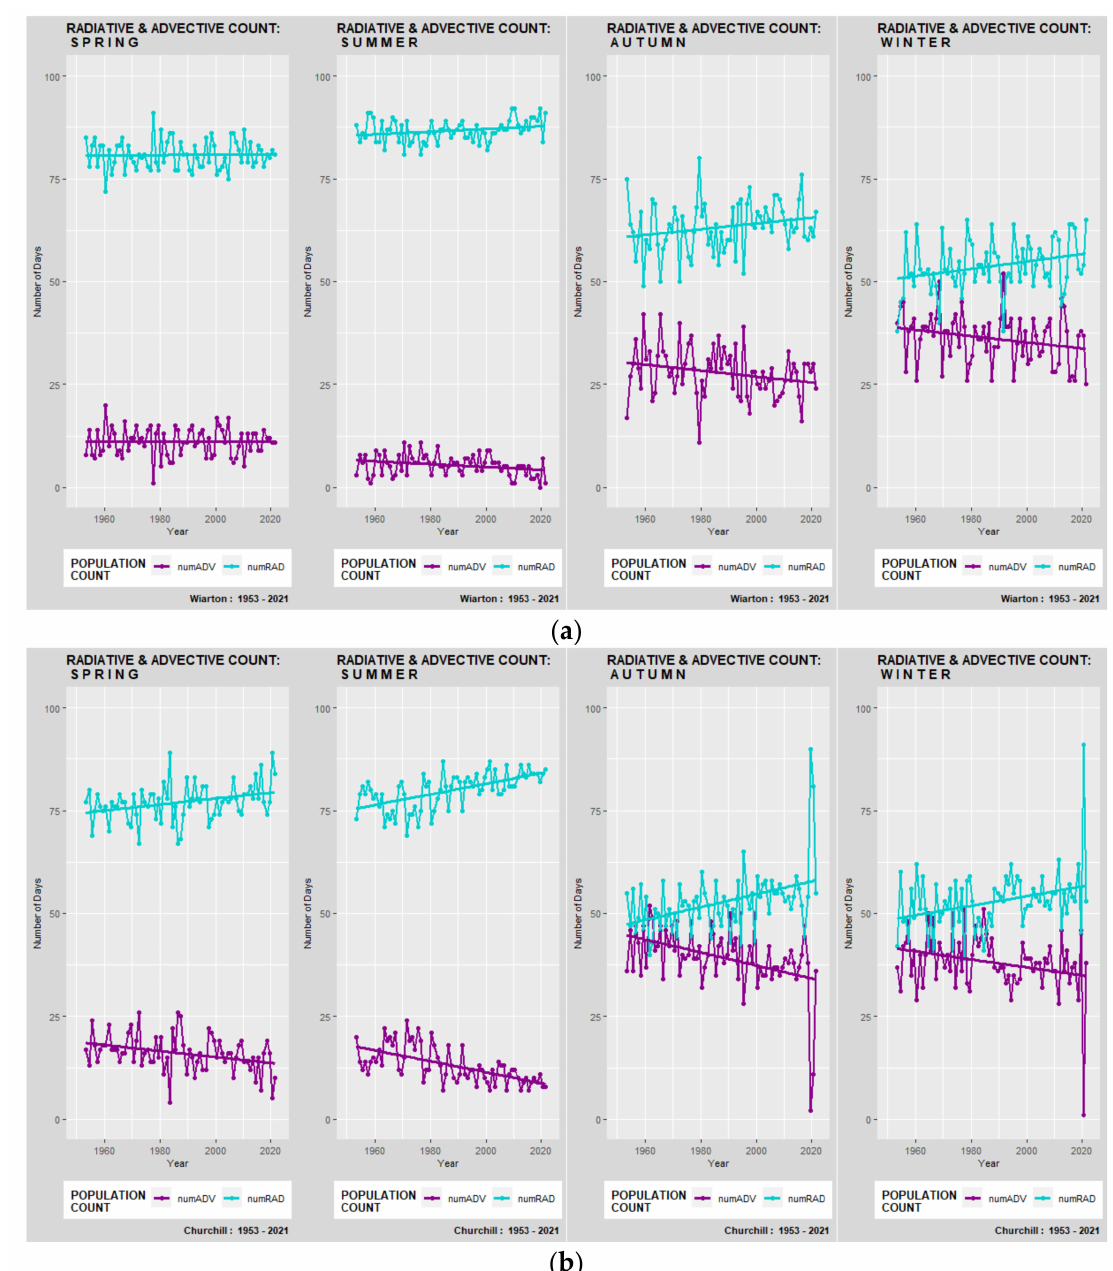
Figure 4. ( a )—Great Lakes/St. Lawrence Lowland (GRL); Wiarton (ON), ( b )—Northeastern Forest (NEF); Churchill (MB). Seasonally averaged radiative and advective temperature population counts, listed in order of Spring, Summer, Autumn, and Winter. ( a )—Radiative Population Count ( RPC ) (cyan blue), and Advective Population Count ( APC )